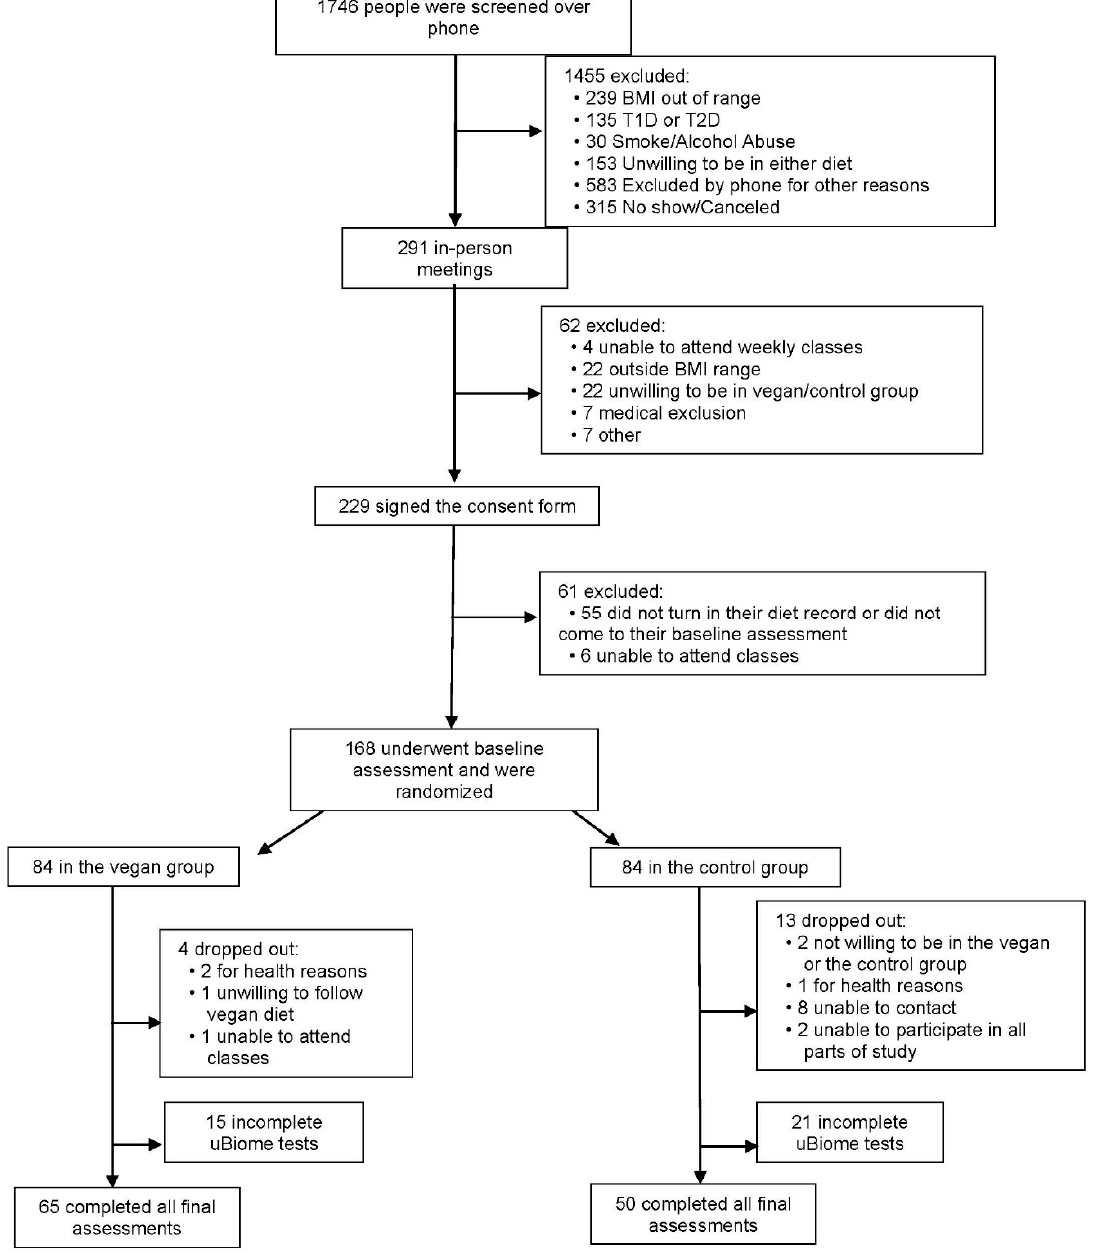
Figure 1. Enrollment of the Participants and Completion of the Study. T1D: type 1 diabetes; T2D: type 2 diabetes.